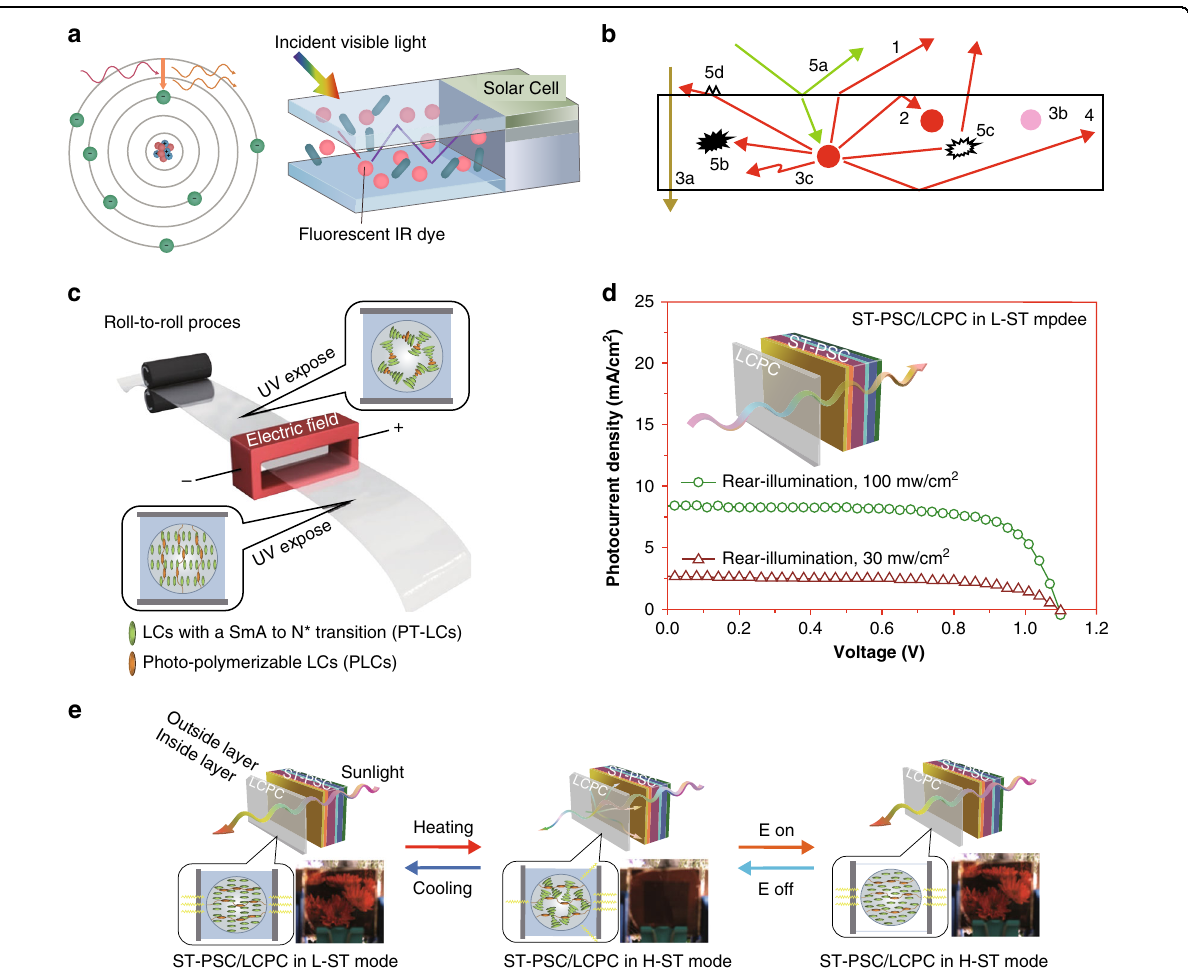
Fig. 20 Self-powered switchable optical devices. a Schematic diagram of the working principle of the luminescent solar concentrator (LSC). b Loss mechanisms in LSCs: (1) Light emitted outside the capture cone; (2) Reabsorption of emitted light by another luminophore; (3a) Input light unabsorbed by the luminophore, (3b) Limited luminophore stability, (3c) Internal quantum ef fi ciency of the luminophore is not unity; (4) Solar cell losses; (5a) Re fl ection from the waveguide surface, (5b) Absorption of emitted light by the waveguide, (5c) Internal waveguide scattering, and (5d) Surface scattering. Reproduced with permission from ref. 183 . Copyright 2012, Wiley Online Library. c Preparation of rolls of multiresponse LCPC fi lms Schematic diagram of the roll-to-roll process. d J – V curves of the back-illuminance of ST-PSC/LCPC under different incident light intensities. e Schematic diagram of the working principle in three modes after combining LCPC fi lms with ST-PSCs. c-e Reproduced with permission from ref. 184